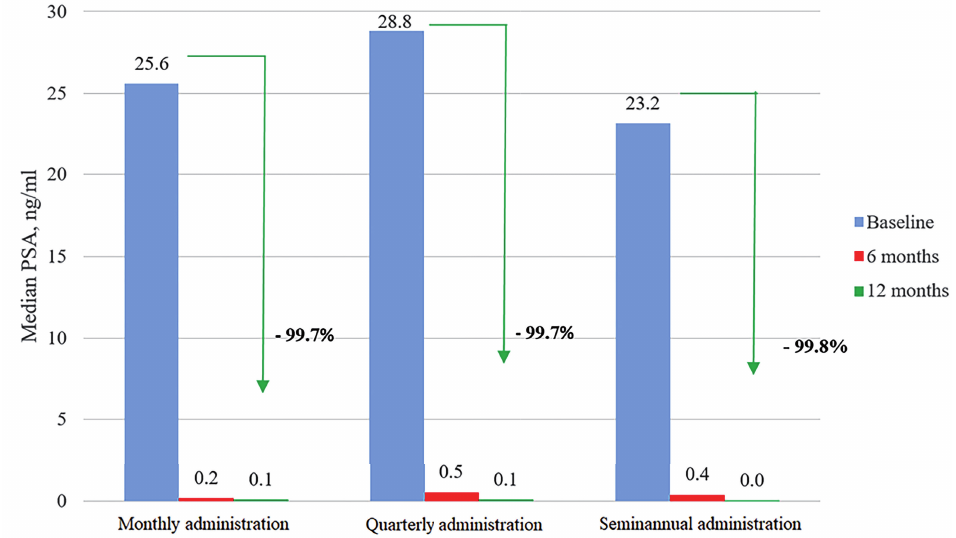
Figure 1 - Median levels of serum prostate specifi c antigen (PSA) in each stratum over